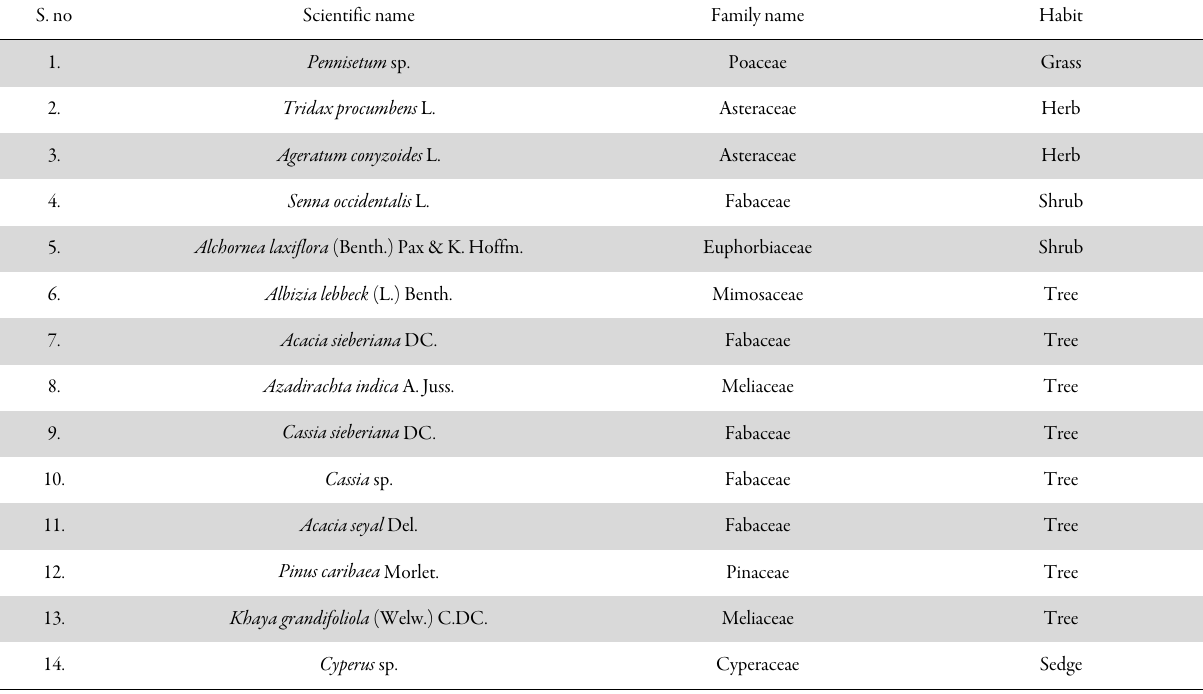
Table 4. Enumerated plants around the study site in Usmanu Danfodiyo University, Sokoto State S. no